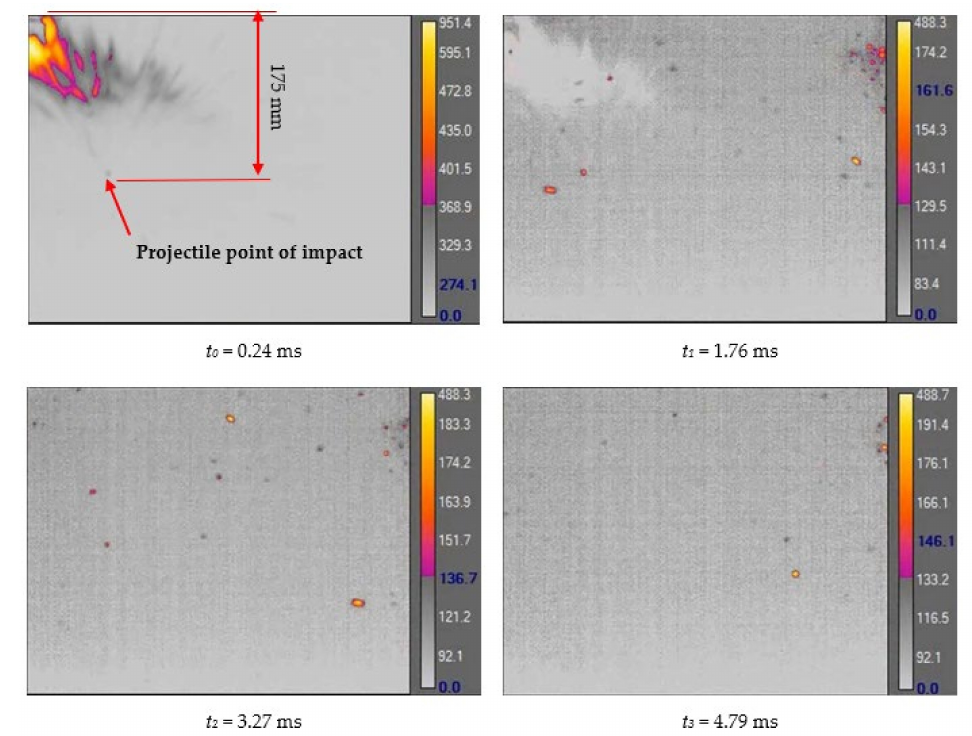
Figure 7. Thermal camera images of projectile impact onto armour